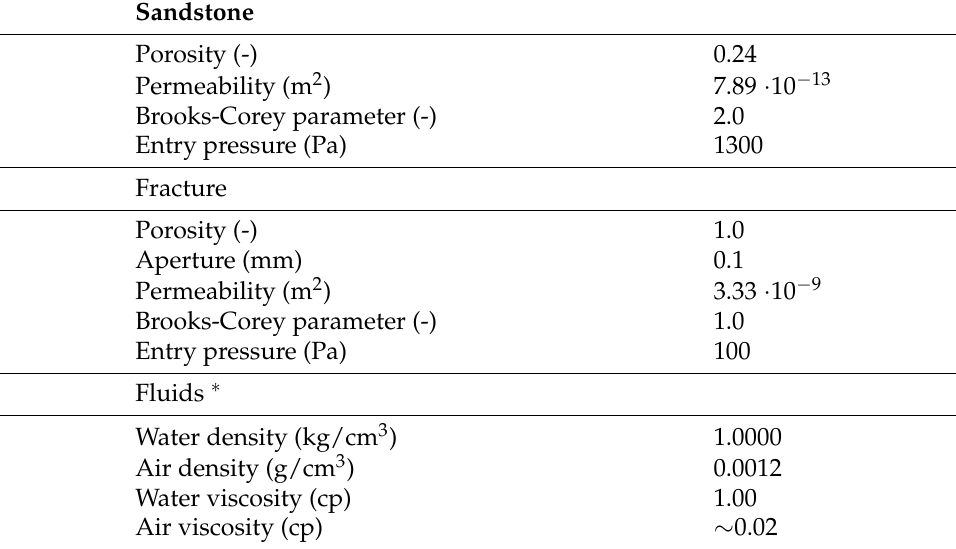
Table 1. Properties used in the construction of the model